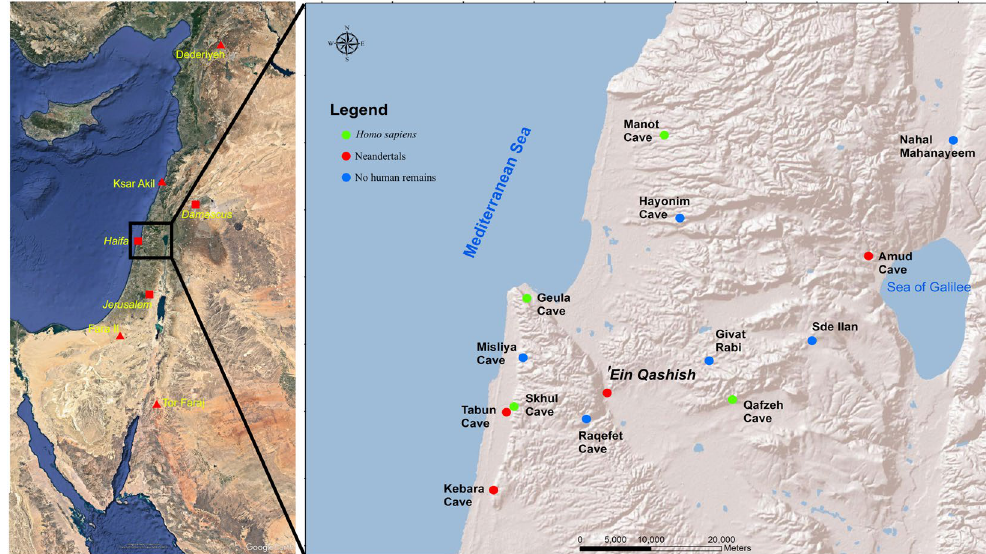
Figure 1. Left: Major Middle Palaeolithic sites (triangles) and modern cities (squares) in the Near East. Right: Location of ‘Ein Qashish and other Middle Palaeolithic sites in northern Israel. The map was generated using ESRI ArcInfo